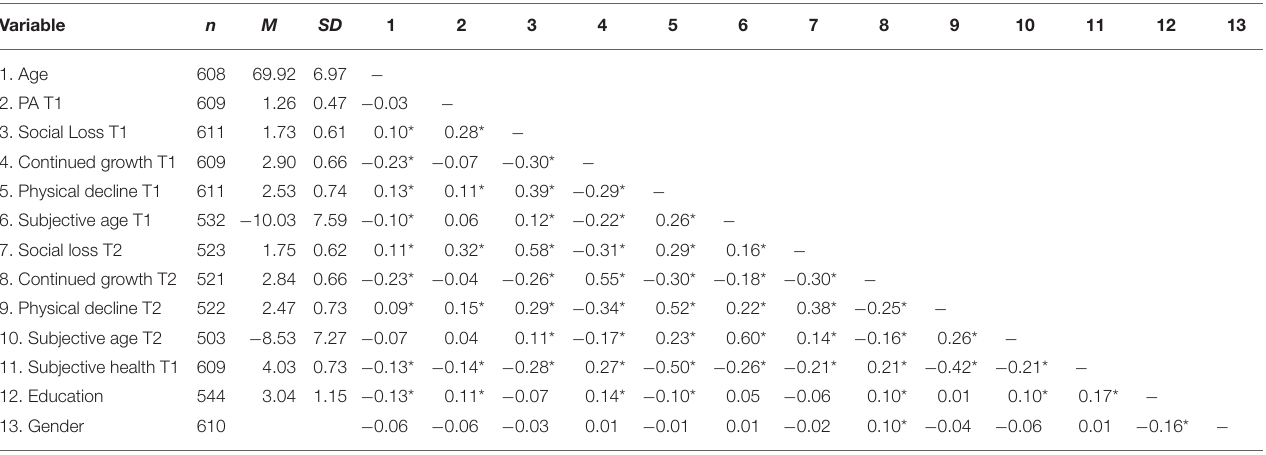
TABLE 1 | Descriptive statistics and manifest bivariate correlations for all study variables. Variable